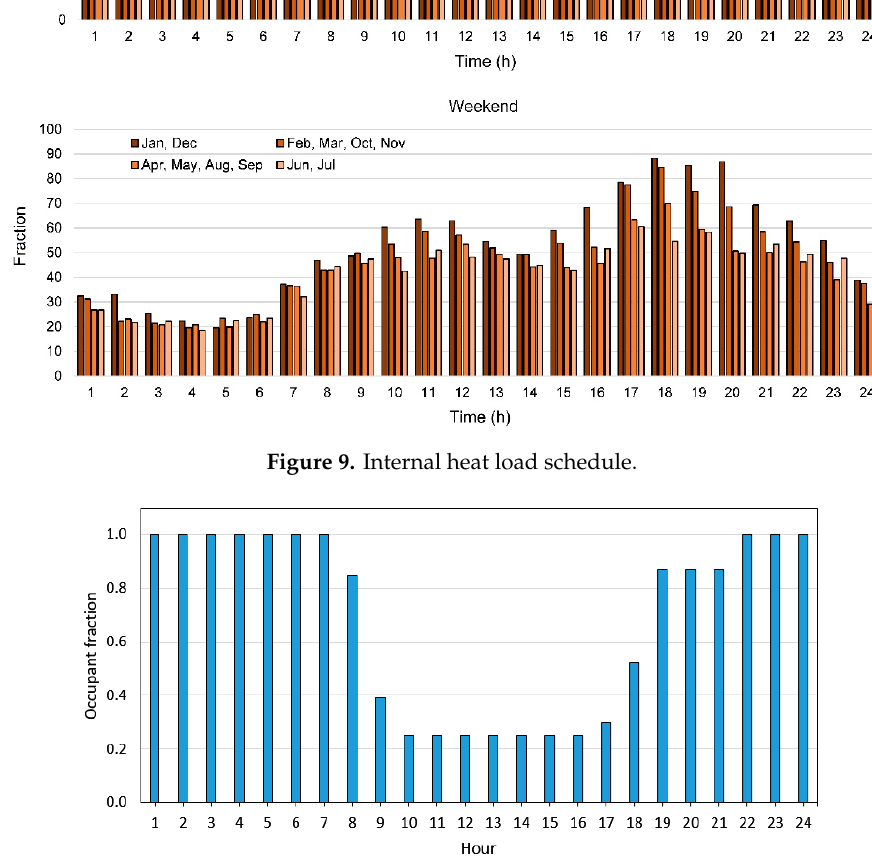
Figure 10. Occupancy schedule.